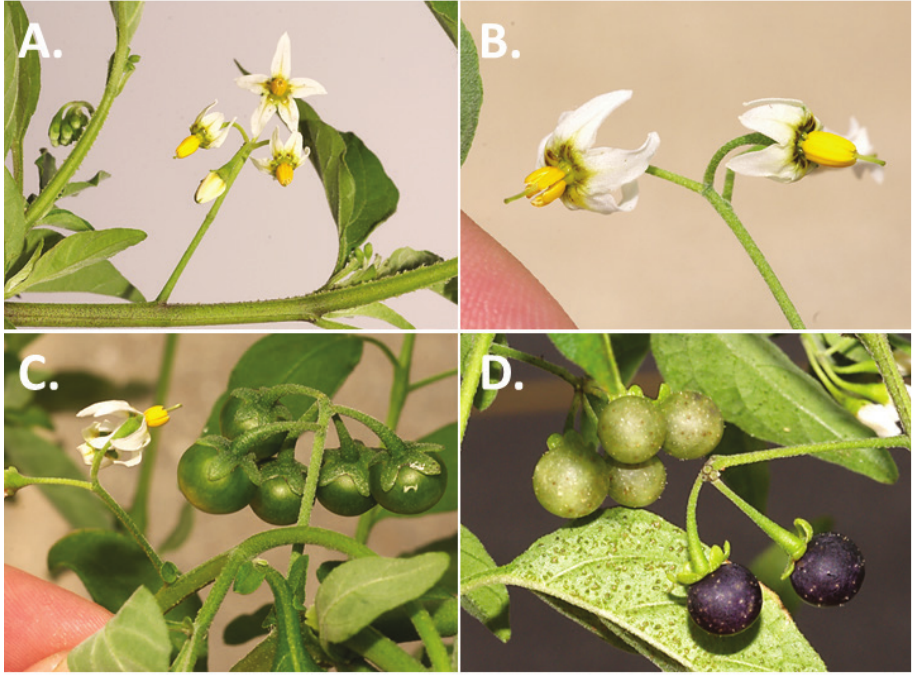
Figure 40. Solanum pseudogracile Heiser. A Flowering branches B flowers at full anthesis C developing fruits D mature fruits ( A, B, D Nee & McClelland 60216 C Nee & McClelland 60224 ). Photos by M. Nee. sparsely to moderately pubescent with simple, appressed, uniseriate eglandular 4–9-celled trichomes, these ca. 0.8 mm long; new growth more densely pubescent. Sympodial units difoliate, not geminate. Leaves simple, (1.3)1.8–8.3(–10.5) cm long, (0.6–)1.1–3.7 cm wide, ovate-lanceolate to narrowly ovate, slightly discolorous, green above and pale grey underneath; adaxial surface sparsely pubescent with appressed translucent, simple, uniseri- ate trichomes like those on stem, these denser along the veins; abaxial surface more densely pubescent like those of the upper surface evenly across lamina and veins; primary veins 3–5(6) pairs; base attenuate to acute, slightly unequal; margins entire to occasionally shal- lowly sinuate dentate; apex acuminate to acute; petiole (0.7–)1.0–2.4 cm long, pubescent with simple uniseriate trichomes like those of the stems and leaves. Inflorescences 1.2–2.0 cm long, lateral, internodal, unbranched or rarely forked, then with rhachis 0.4–0.5 mm long, with 3–8 flowers spaced along the rhachis, sparsely pubescent with appressed simple uniseriate trichomes like those on stem; peduncle 1.2–1.8 cm long, straight; pedicels 5–8 mm long, 0.2–0.3 mm in diameter at the base and 0.5–0.6 mm in diameter at the apex, straight and spreading, articulated at the base; pedicel scars spaced ca. 0–1 mm apart. Buds ellipsoid, corolla exserted from the calyx to 2/3 of its length. Flowers 5-merous, all perfect. Calyx tube 1.0–1.5 mm long, the lobes 0.5–1.0 mm long, ca. 1 mm wide, broadly ovate to obovate with obtuse to shortly acute apices, sparsely pubescent with appressed hairs like those on stem but shorter. Corolla 10–12 mm in diameter, deeply stellate, white with a yellow-green central portion near the base, some with darker blackish-purple